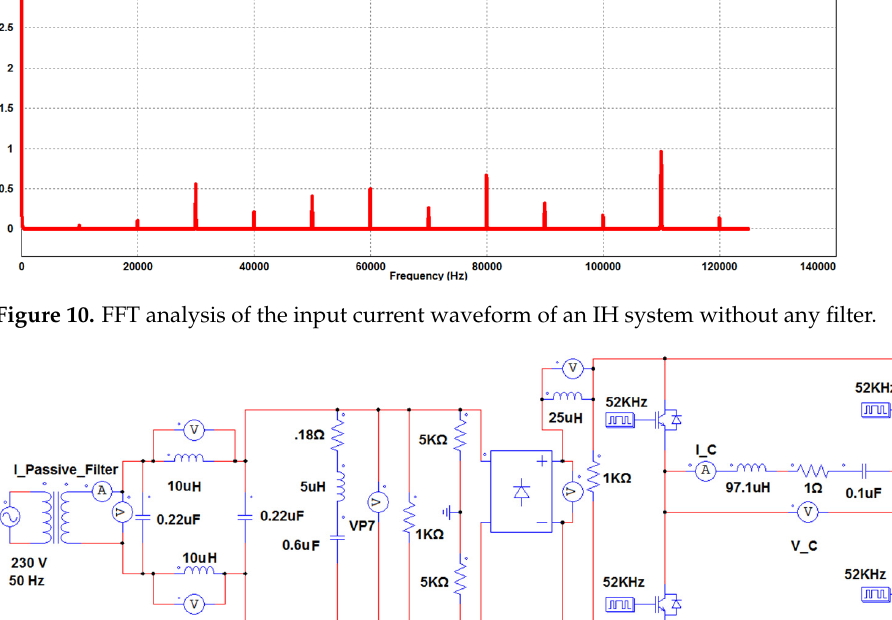
Figure 12. Input current waveform of an IH system with a passive filter. Figure 13. FFT analysis of the input current waveform of an IH system with a passive filter. Figure 14. Simulation circuit diagram of an IH system with a conventional VR.